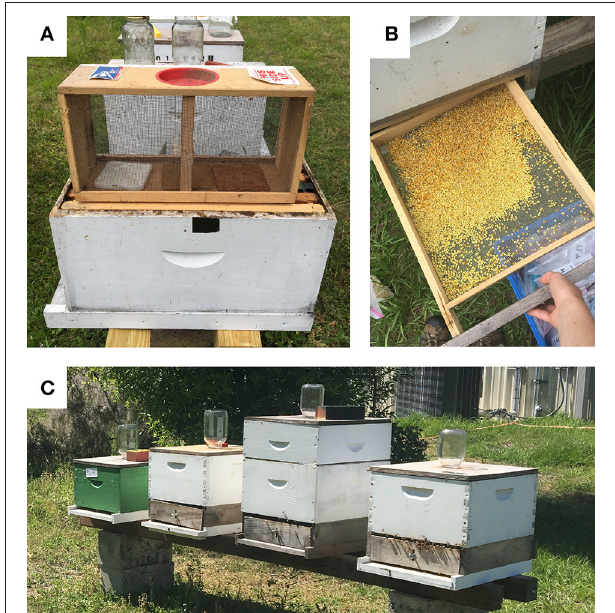
FIGURE 2 | (A) An empty package used to exclude bees from evaporative control diets. (B) A pollen sample from a sentinel colony fitted with a pollen trap. (C) Multiple sentinel colonies fitted with pollen traps used to monitor pollen availability during a pollen substitute study.